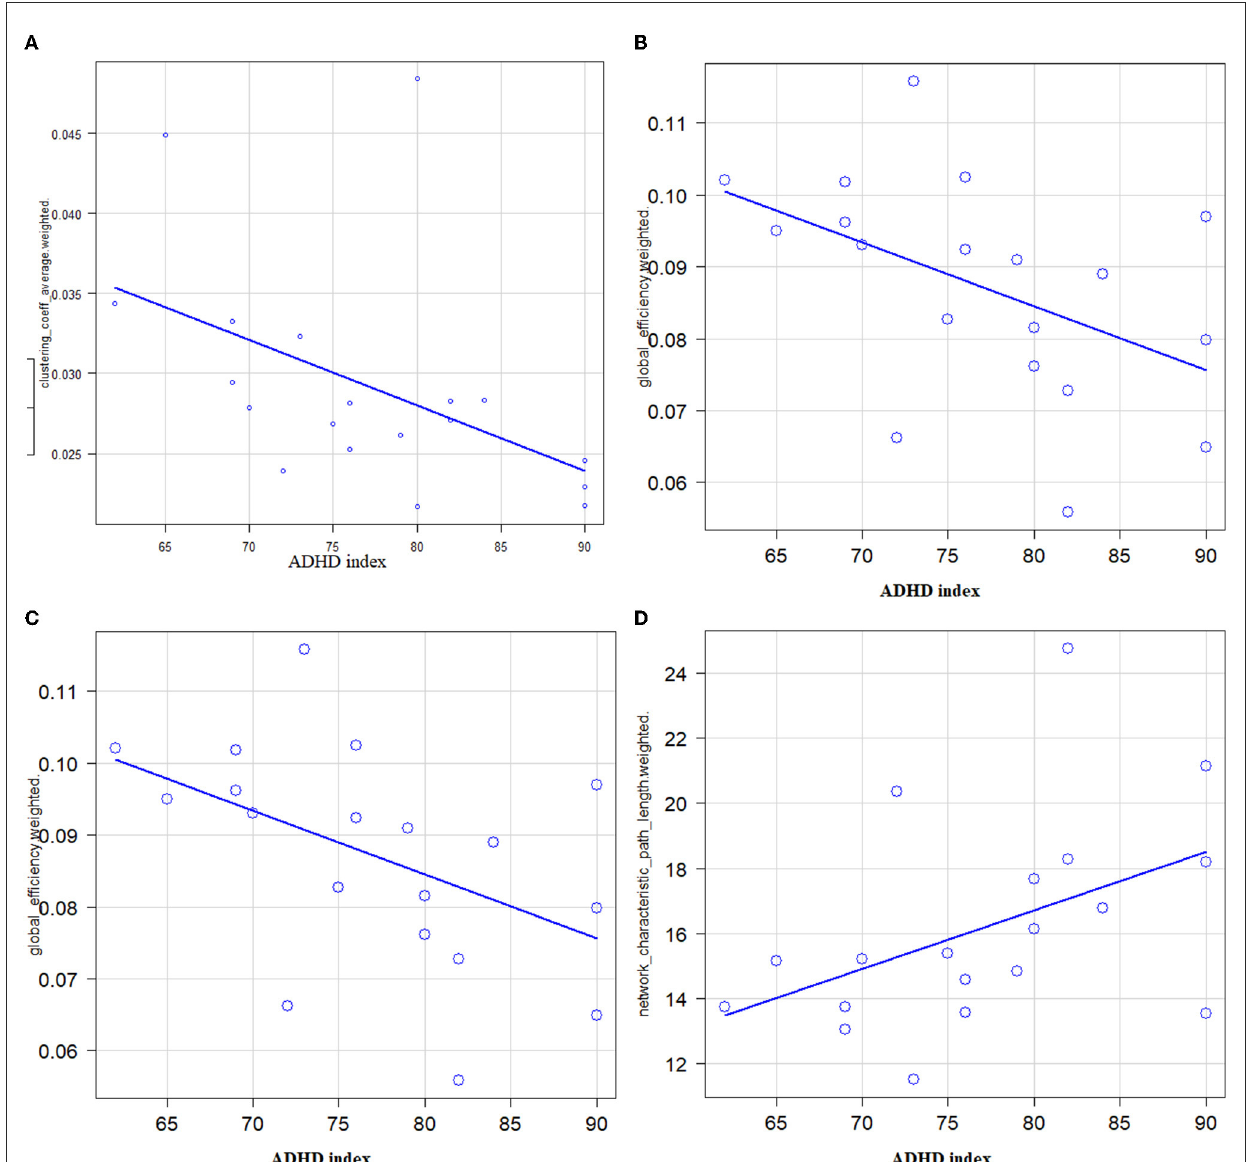
FIGURE1 Correlations between ADHD symptoms (X: T-score of ADHD index) and global network metrics (Y) in patients with adult ADHD. (A) A significantly negative correlation between the T-score of the ADHD index and the global efficiency was noted ( r = − 0.481, 95% CI − 0.768– − 0.0346, P = 0.037). (B) A significantly negative correlation between the T-score of the ADHD index and the clustering coefficient was noted ( r = − 0.56, P = 0.0127). (C) A significantly negative correlation between the T-score of the ADHD index and the small worldness was noted ( r = − 0.603, 95% CI − 0.83– − 0.205, P = 0.0062). (D) A significantly positive correlation between the T-score of the ADHD index and the characteristic path length was noted ( r = 0.454, 95% CI 0.000629–0.753, P =